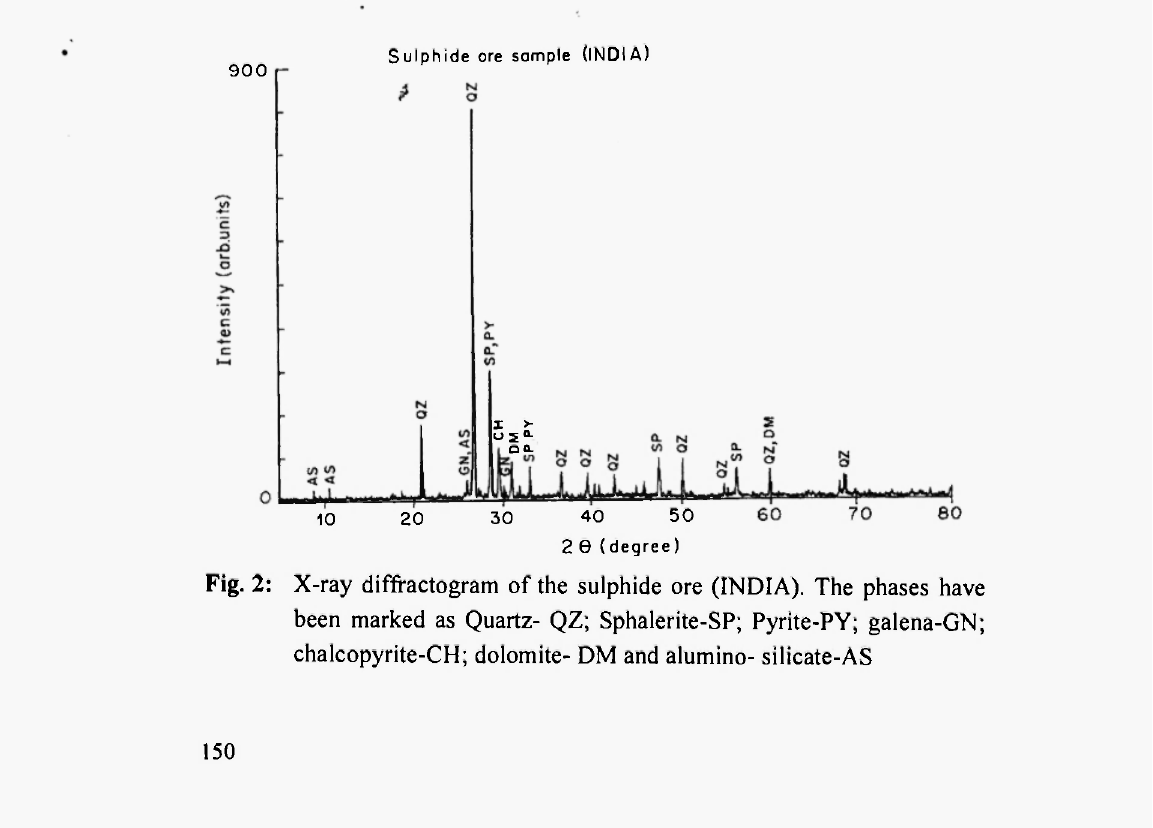
X-ray Diffractogram of the reference ore sample RM RDF (HZL). Fig. 1: